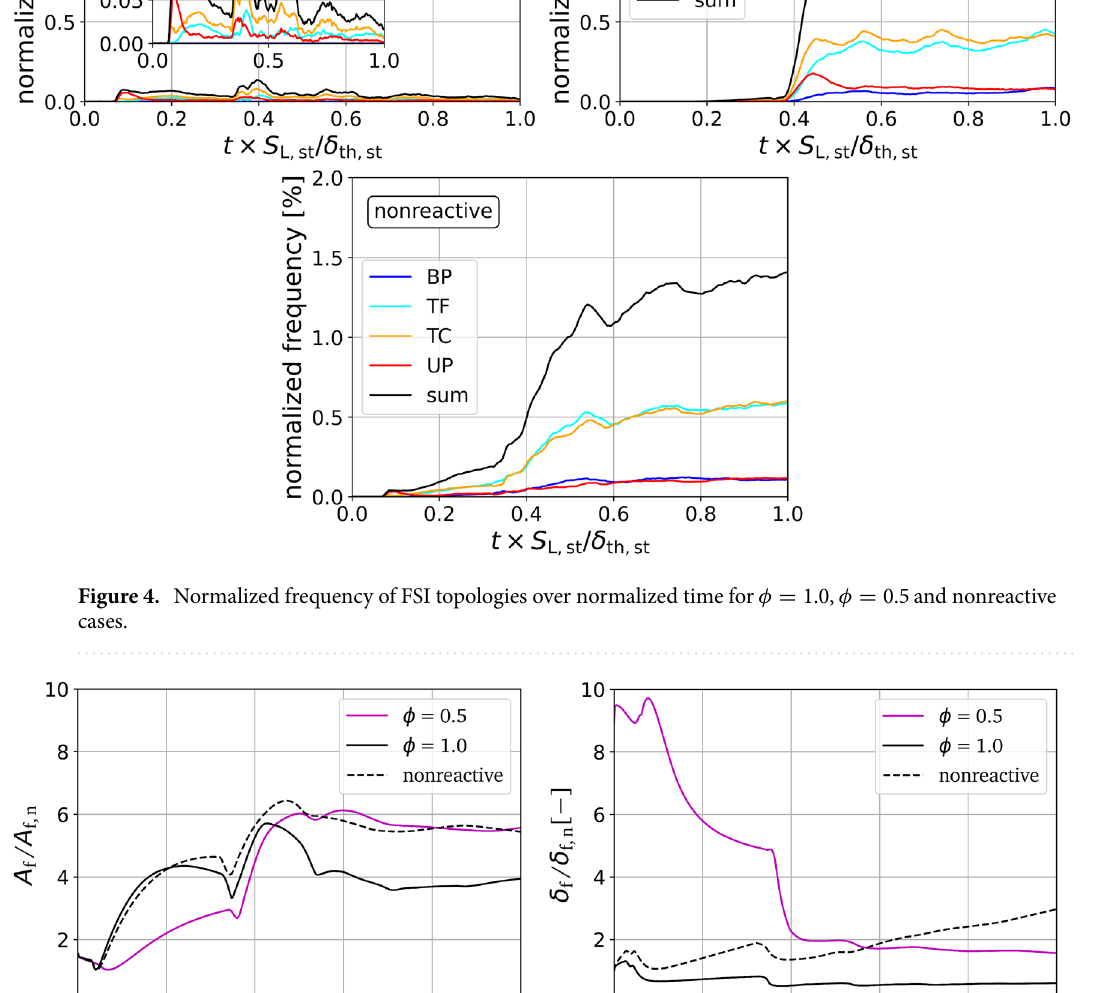
Figure 5. Normalized flame surface area (left) and normalized flame thickness (right) over normalized time for φ 1.0 , φ 0.5 and nonreactive = =